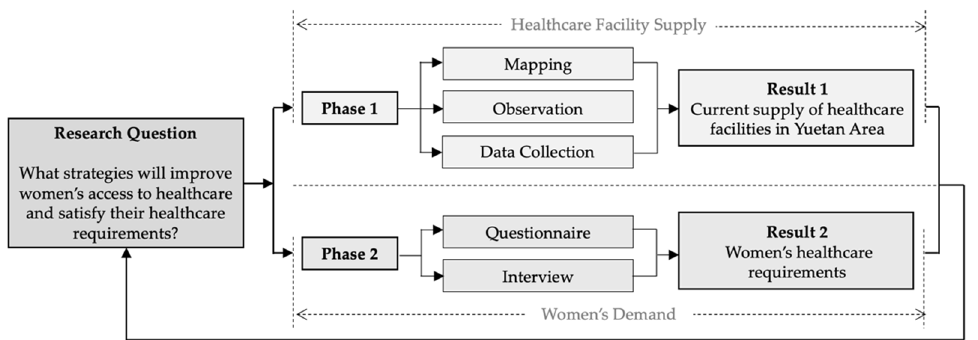
Figure 2. Methodological framework.